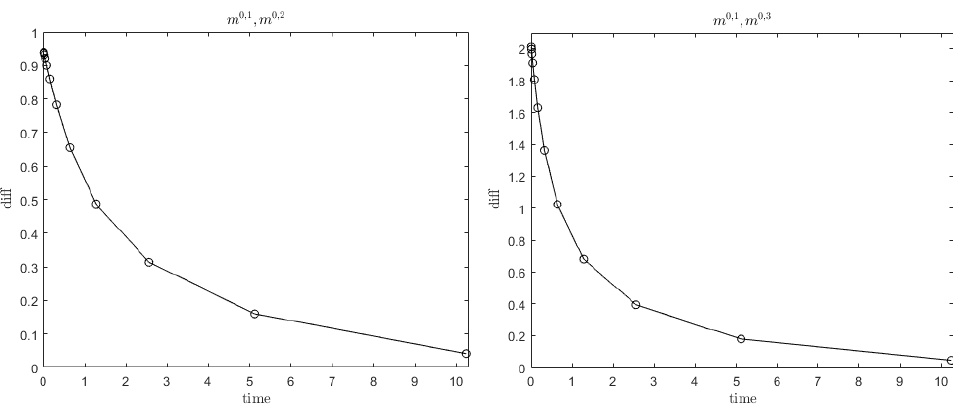
Figure 7. In this figure, we show the difference between two different solutions choosing, as initial conditions, m 0,1 , m 0,2 ( left ) and m 0,1 , m 0,3 ( right ). We plot the expression defined in Equation (49) as a function of time, with γ = 1.75 > 1, and the others parameters are defined in T EST D. In Figure 8, which is the case for γ < 1, we see that we reach two different steady states when choosing two different initial conditions, suggesting that the steady state solution is not unique when γ < 1.